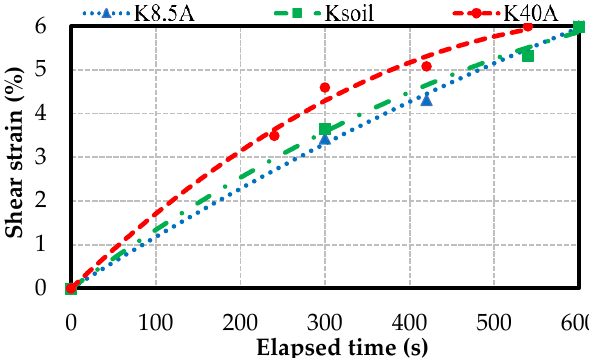
Figure 15. Change in rainfall-induced shear strain over time.